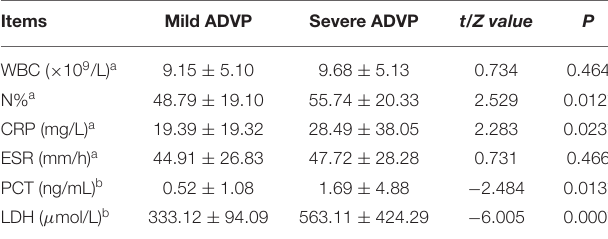
TABLE 1 | Comparison of inflammatory indicators between the mild ADVP group and the severe ADVP group.